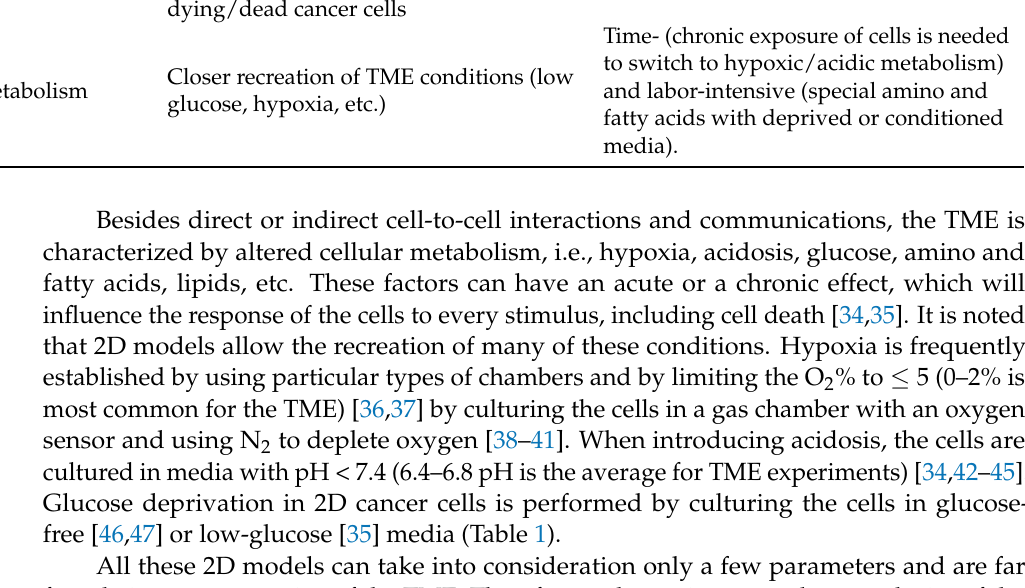
Table 1. Advantages and disadvantages of 2D TME models and assays.